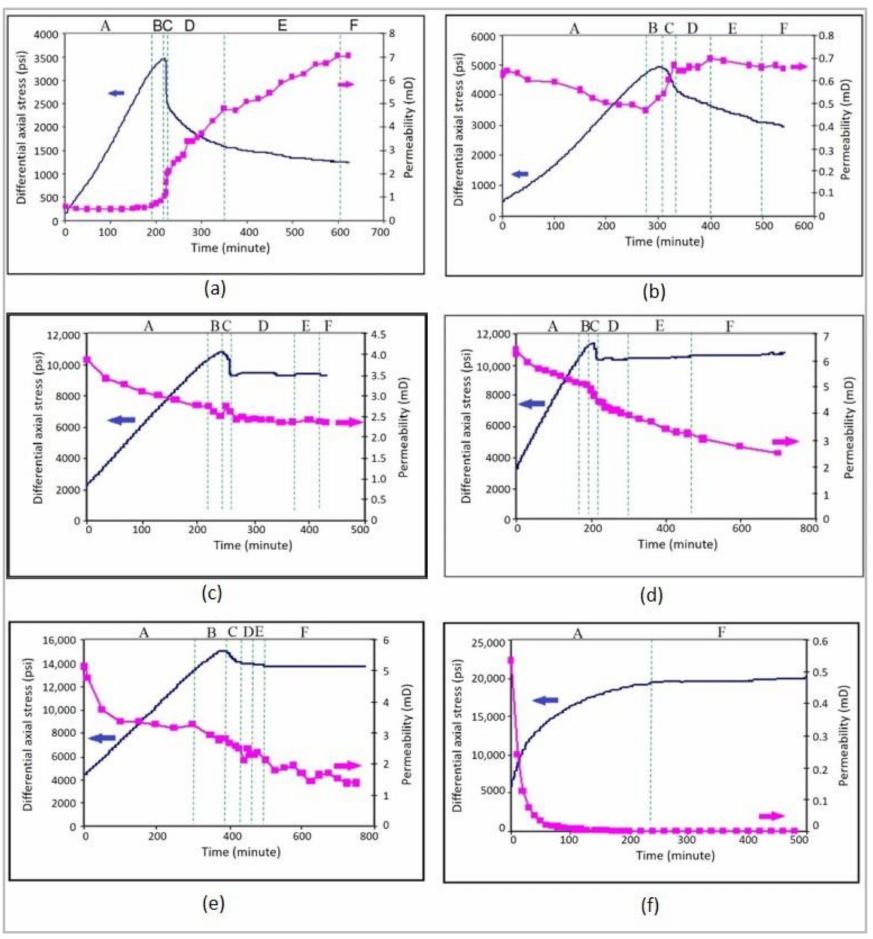
Figure 6. Impact of failure mode on permeability/fracture conductivity. Axes: X—time, Y 1 (left, blue curve)—differential axial stress, Y 2 (right, pink curve)—permeability/fracture conductivity. Failure mode: ( a )—brittle; ( b )—semi-brittle; ( c – e )—semi-ductile; ( f